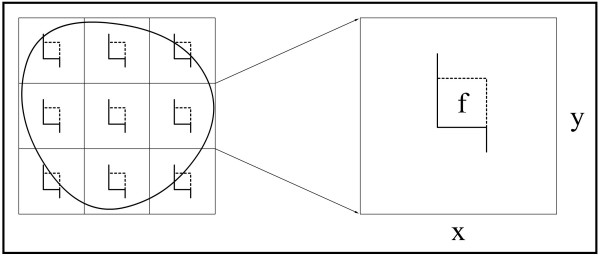
The counting principle of the axon number in nerve cross-section. The section of nerve is sampled in a systematic random manner to gain an unbiased estimation of total axon number in a nerve. Each square represents a sampling area. An unbiased counting frame is seen in the center of this area. The axons are counted if nerve fiber being in the unbiased counting frame (f) in each sampling area. Estimates of the total number of myelinated axons are calculated as the product of the number of axons counted in a known fraction and multiplied by the inverse sampling fraction. In this study, upper and right lines of unbiased counting frames represent the inclusion lines (dot lines) and the lower and left lines including the extensions are the exclusion lines. Any profile of myelinated nerve fiber section hitting the exclusion lines is excluded and profile of nerve fiber hitting the inclusion lines and located inside the frame are counted.